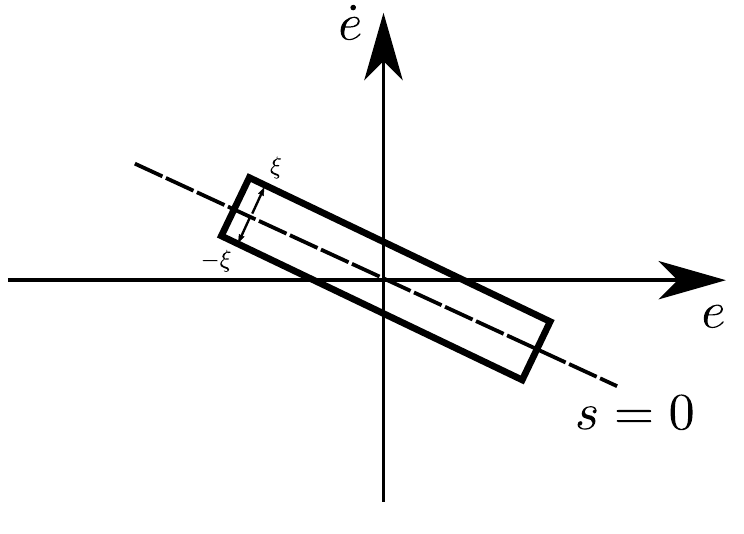
Figure 5. Fuzzy sliding